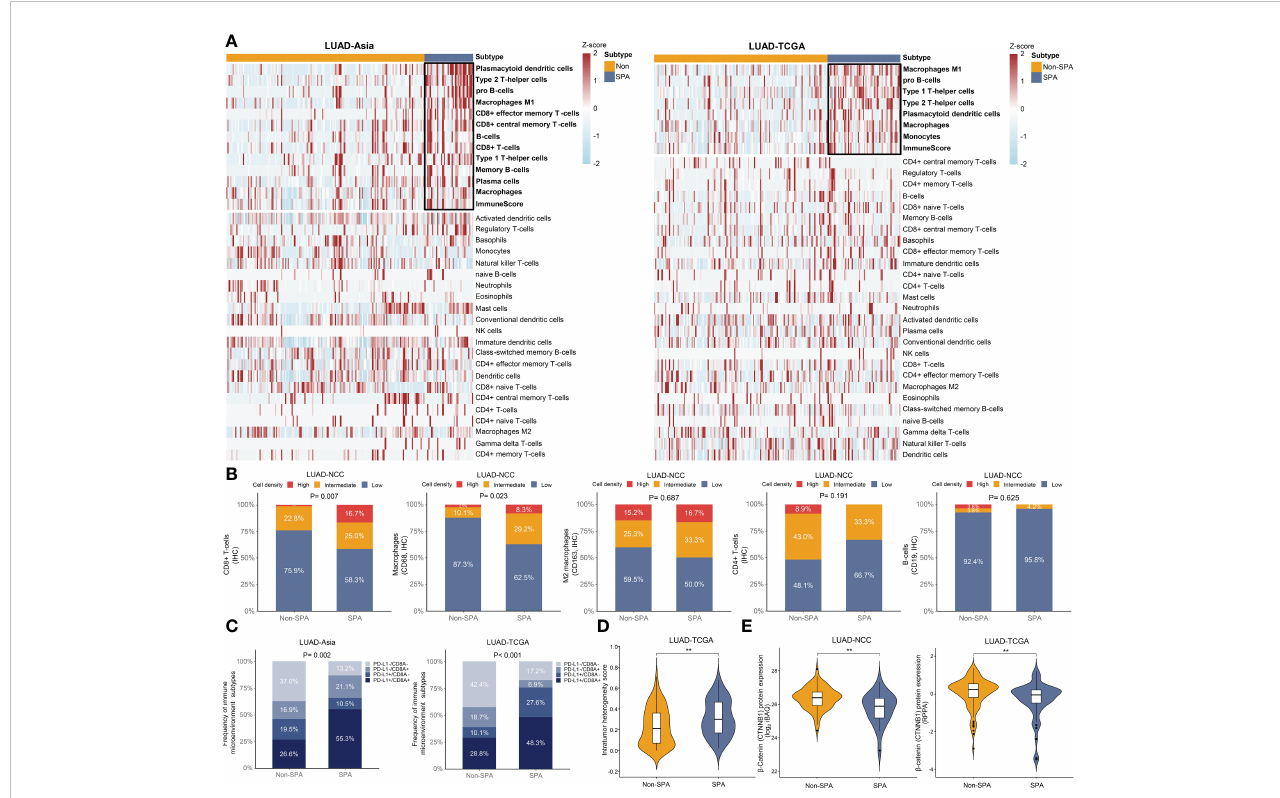
FIGURE 6 Tumor immune microenvironment of SPA and Non-SPA. (A) Tumor immune microenvironment of SPA and Non-SPA. (B) Immunohistochemistry evaluation of CD8+ T-cells, macrophages (CD68), M2 macrophages (CD163), CD4+ T-cells and B-cells (CD19) in SPA and Non-SPA in LUAD-NCC. (C) Correlation between pathological subtypes (SPA versus Non-SPA) and the four types of tumor immune microenvironment classi fi ed based on PD-L1 and CD8A expression. (D) Comparison of intra-tumor heterogeneity scores between SPA and Non-SPA in LUAD-TCGA. (E) Comparison of b -Catenin protein levels between SPA and Non-SPA in LUAD-NCC and LUAD-TCGA. SPA, solid predominant adenocarcinoma; Non-SPA, non-solid predominant adenocarcinoma; IHC, immunohistochemistry; RPPA, reverse phase protein array. **P <